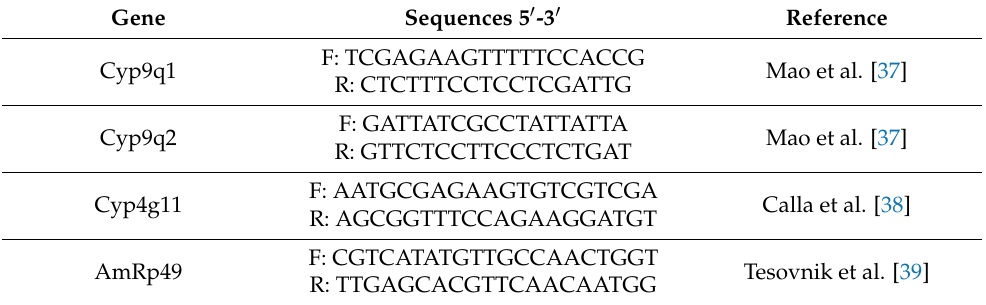
Table 2. Primers for qPCR